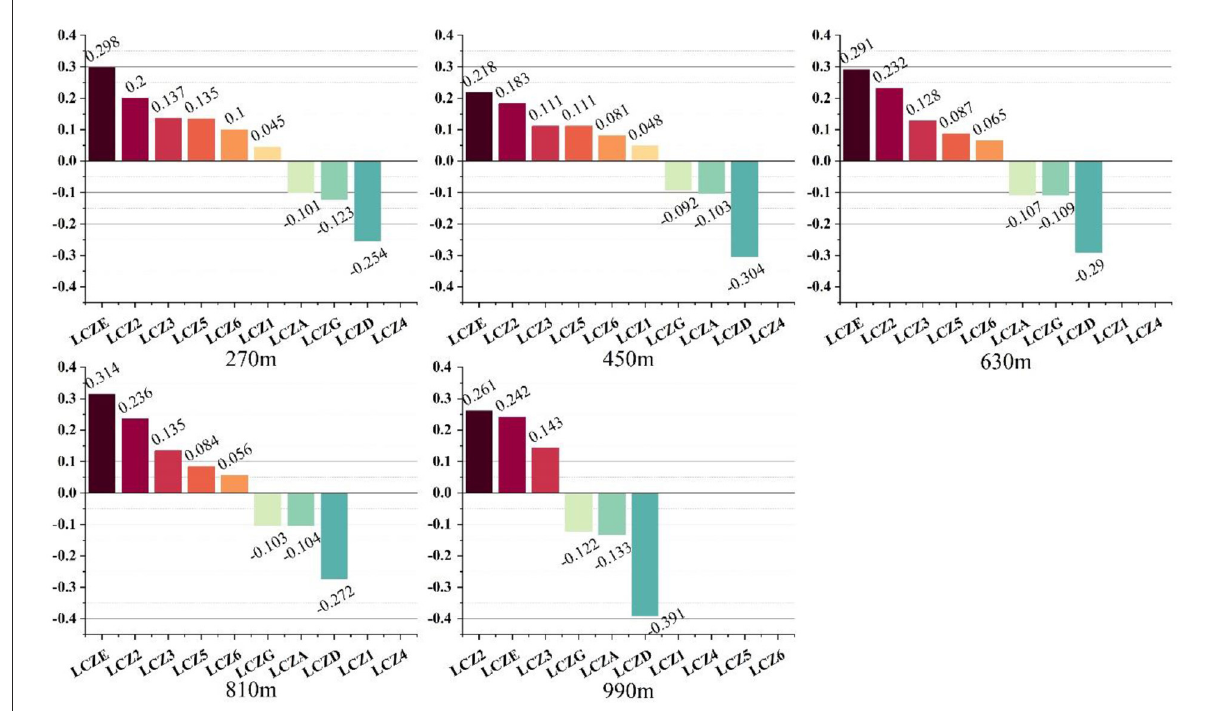
FIGURE7 Normalized coefficients of various LCZ and LST regression models under the combined